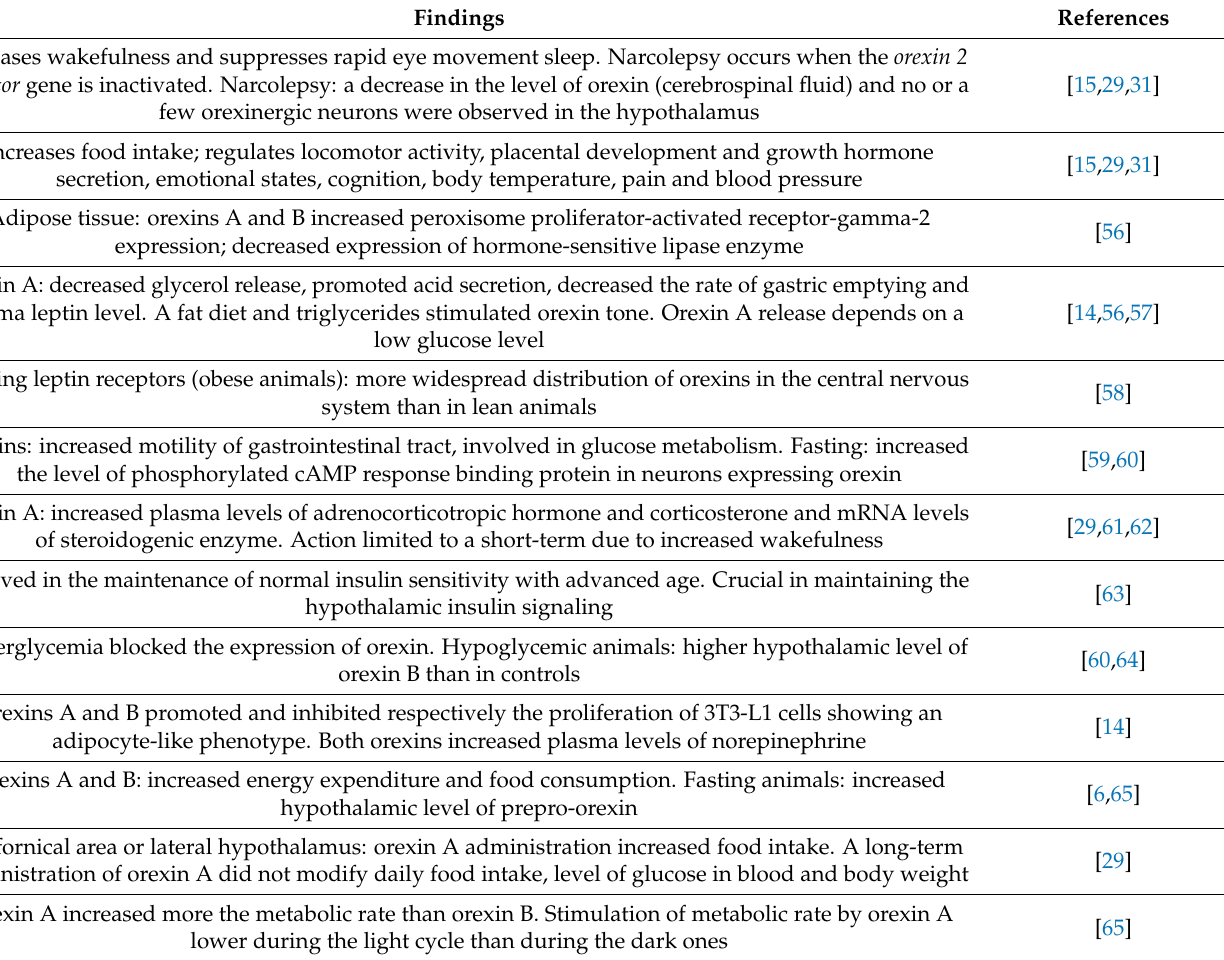
Table 2. Orexins: physiological actions and pathological conditions.